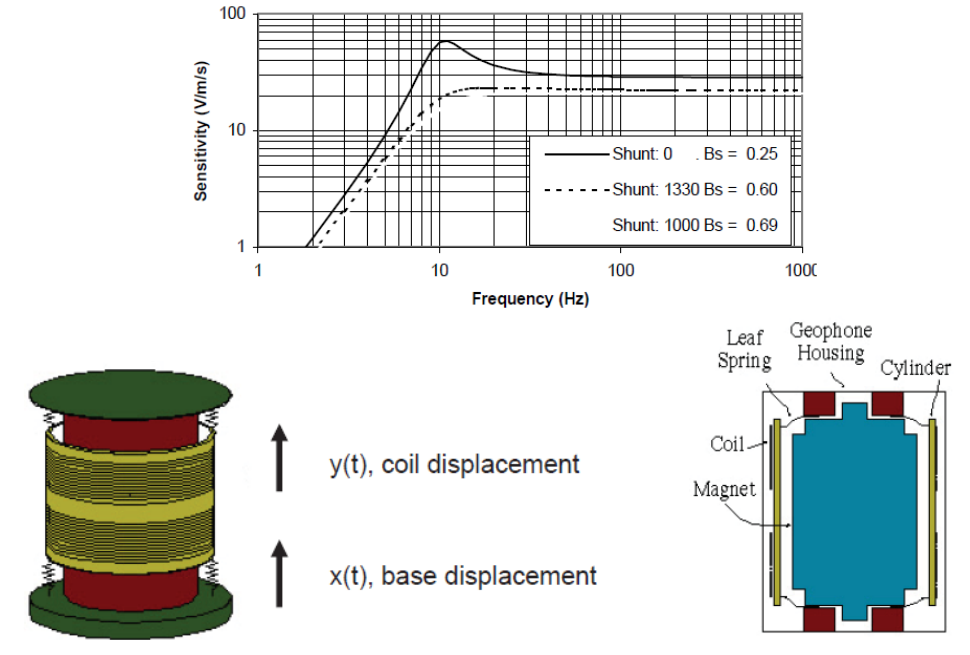
Figure 8. Characteristic curve sensitivity/frequency of the SM-6 sensor (28.8 V/m/s is a maximum sensitivity at 8 Hz from Input-Output Company, Stafford, TX, USA). An electromagnetic sensor diagram.